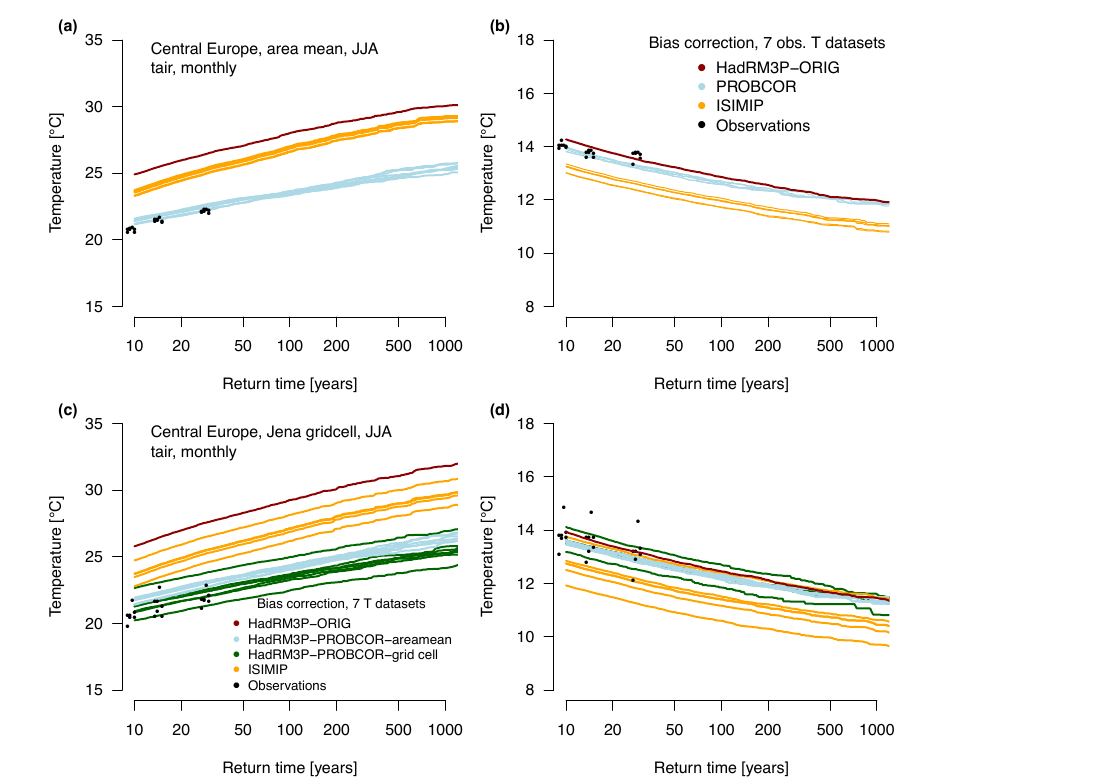
Figure 4. Return times of hot (a, c) and cold (b, d) temperature extremes in summer (JJA) in the original regional model simulations (“ORIG”), in the resampled ensemble (“PROBCOR”) and the mean-adjusted ensemble (“ISIMIP”). Plots are shown as spatial averages over Central Europe (top panels) and for an illustrative grid cell (Jena, bottom panels). Black dots in each plot indicate empirical return times estimated from observations taken from seven different data sets that were used for bias